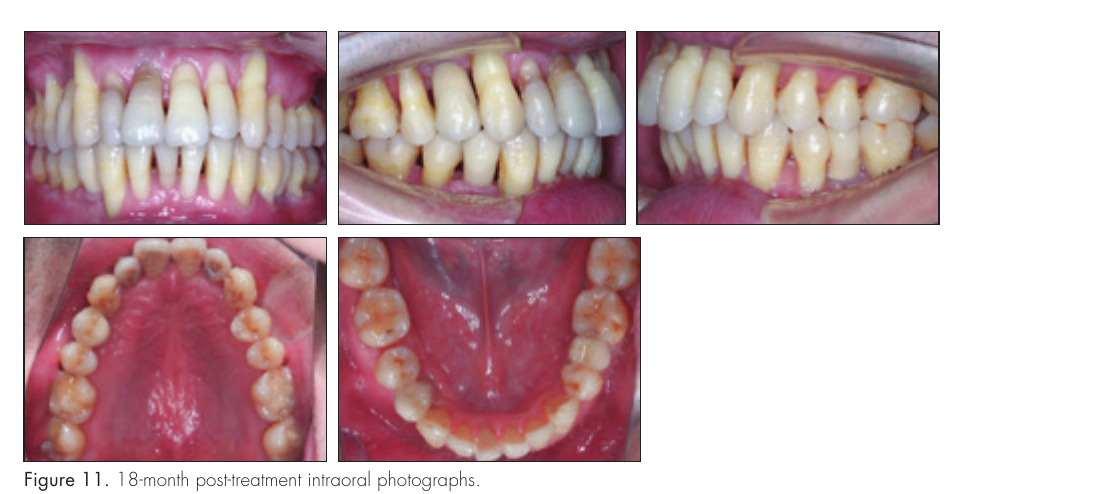
Figure 10. (A, B, C) Post-treatment radiographs and superimposition; (D, E, F, G) According to the panorama, the height of the alveolar bone increased in some areas. D. The height of the alveolar bone between lower right first and second molars before treatment; E. The height of the alveolar bone between lower right first and second molars after treatment. F. The height of the alveolar bone between the upper left central and lateral incisors before treatment; G. The height of the alveolar bone between the upper left central and lateral incisors after treatment.